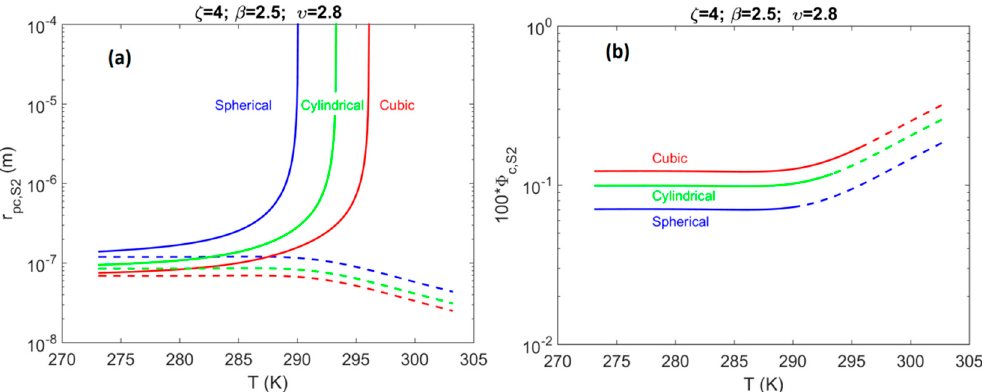
Figure 10. System of a single pore-body connected with 4 cubic pore-throats (i.e., system S2); ( a ) effect of pore-body geometry (spherical—blue; cylindrical—green; cubic—red) on the critical pore-body radius, r pc , S 2 , plotted as a function of temperature along the three-phase (H–L w –V) equilibrium line for the methane + water system (modified from Tsimpanogiannis [60]). ( b ) Effect of different pore-body geometries for system S2 on the value of ( 100 ∗ Φ c , S 2 ) , plotted as a function of temperature along the same three-phase equilibrium line. Solid lines correspond to pores located at the hydrate-dissociation front ( P l = P bulk eq ) , while the dashed lines correspond to pores at minimum pore pressure ( P = 0 ) for well production via a pressure depletion scheme.